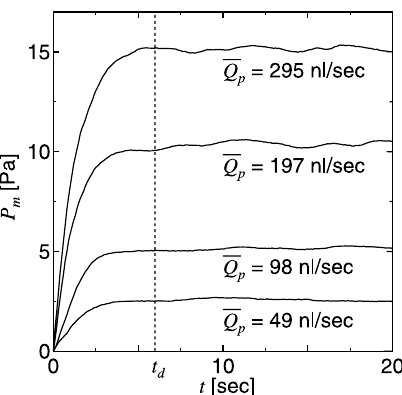
Fig. 9 The time series of the measurement pressure P m after pumping starts.